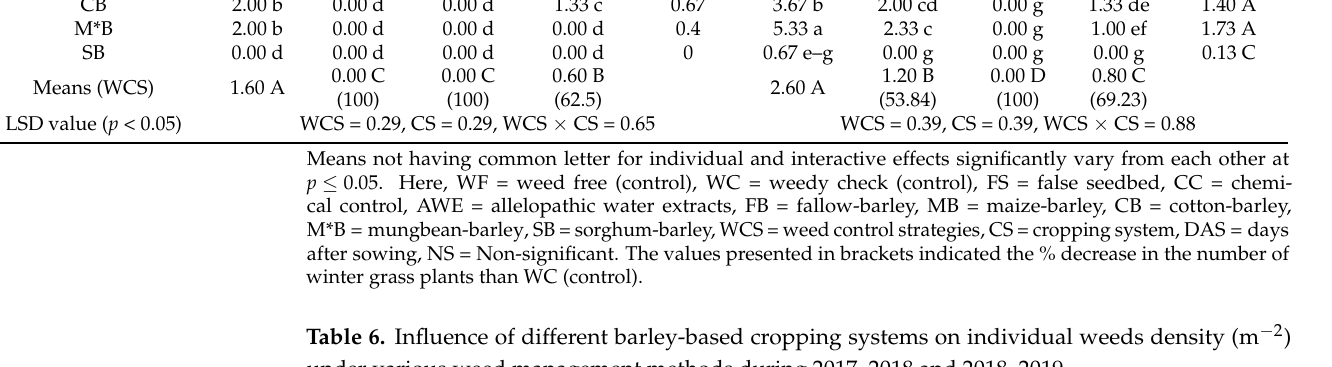
Table 6. Influence of different barley-based cropping systems on individual weeds density (m − 2